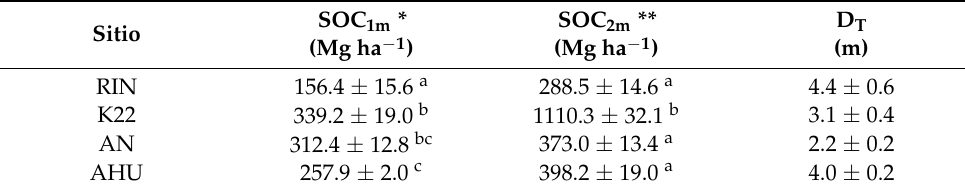
Table 3. Average soil organic carbon (SOC) ± SE at 0–1 m and 0–2 m depth. Soil depth = D T . Sitio